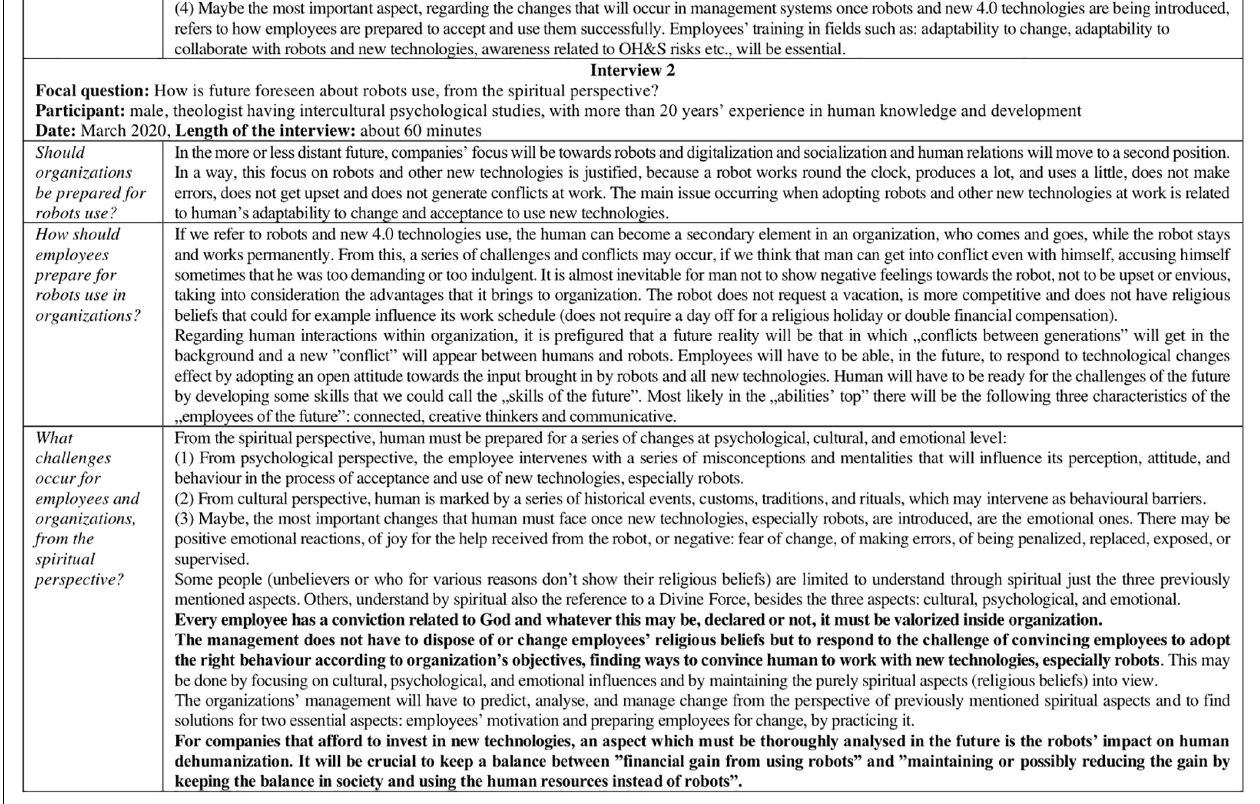
FIGURE 1 | Outputs of the first round of